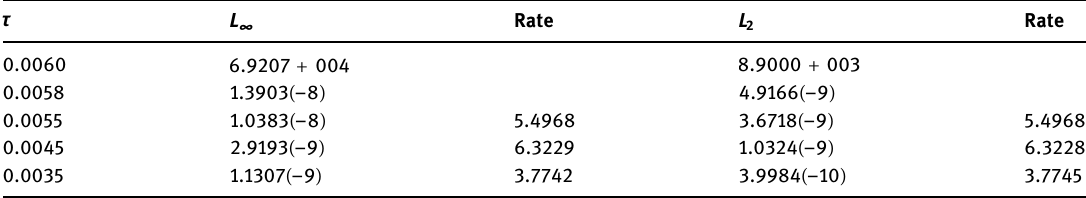
Table 2: L 2 , L ∞ errors and rate at = T 1 and = h 0.008 by the HOC - LOD scheme for variable τ for Example 1 τ L